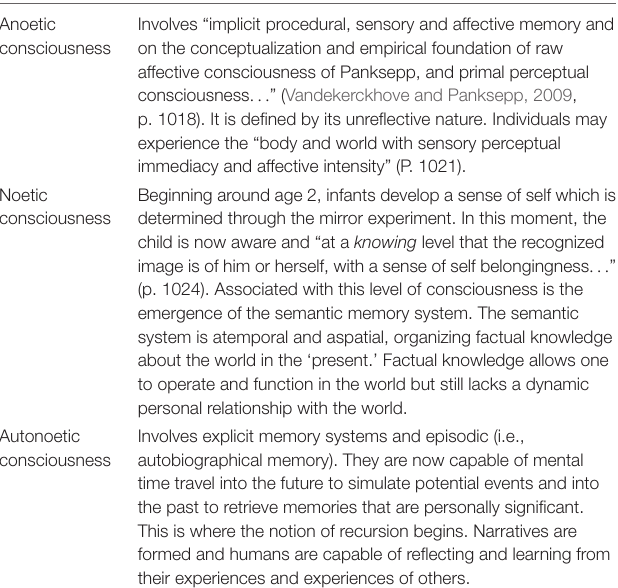
TABLE 1 | Three phases of